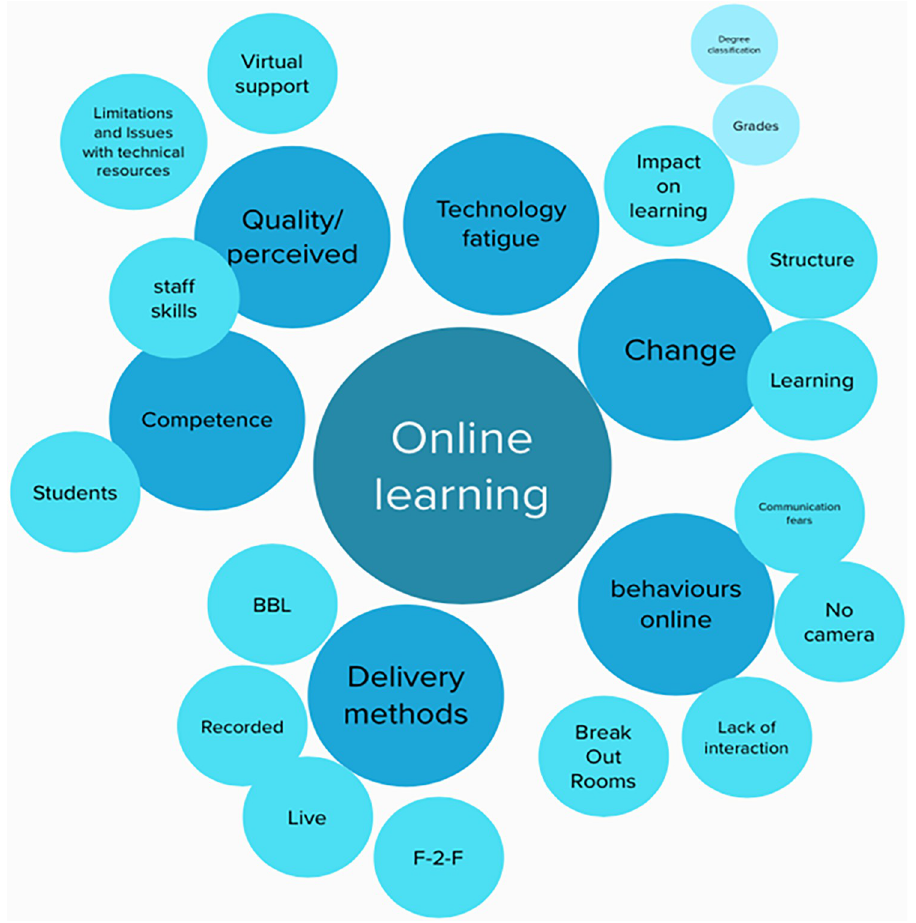
Fig 1. An example (screenshot) of an early stage of co-developing themes using the platform